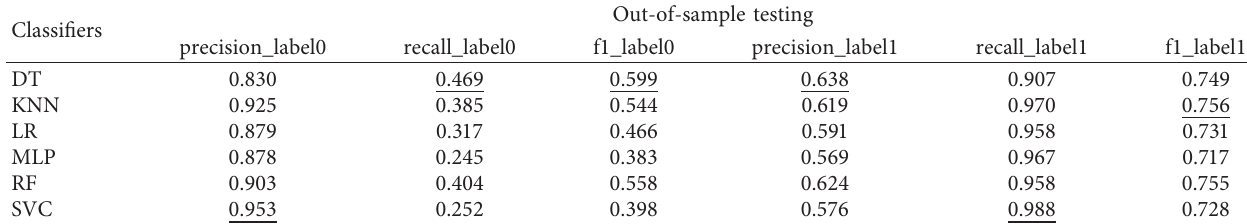
Figure 6: Sample case five (nonnight setback, random profile). Table 5: Out-of-sample testing of models with original features.